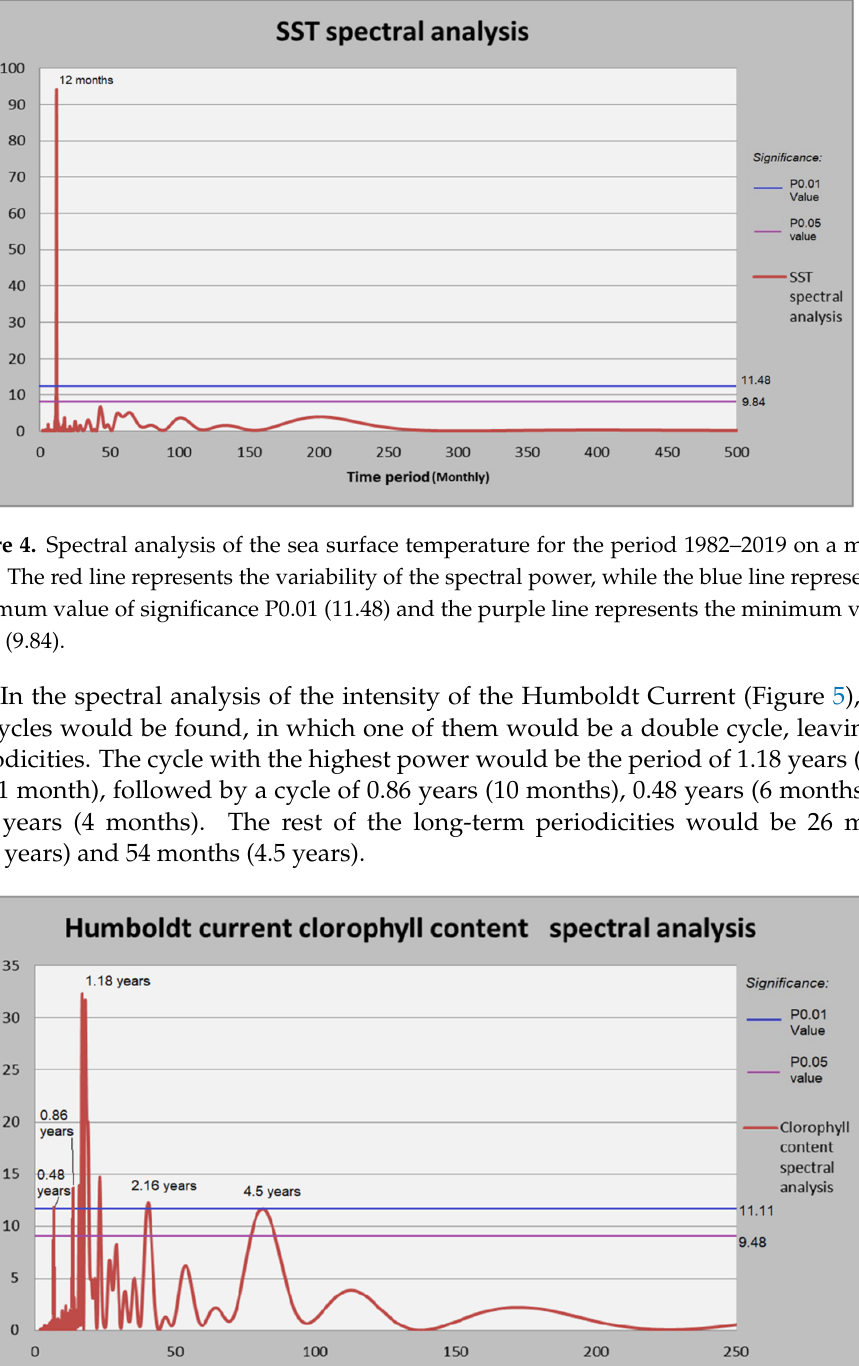
Figure 3. Spectral analysis of the ONI index for the period 1950–2019 on a monthly scale. The red line represents the variability of the spectral power, while the blue line represents the minimum value of significance P0.01 (12.06), and the purple line the minimum value of P0.05 (10.43). In the matter of the SST (Figure 4), a single cycle of great power is observed, referring to 12 months (1 year). There would be a second cycle of 44 months (4 years), but it would not reach any of the minimum significances, not even the P0.05 significance level.